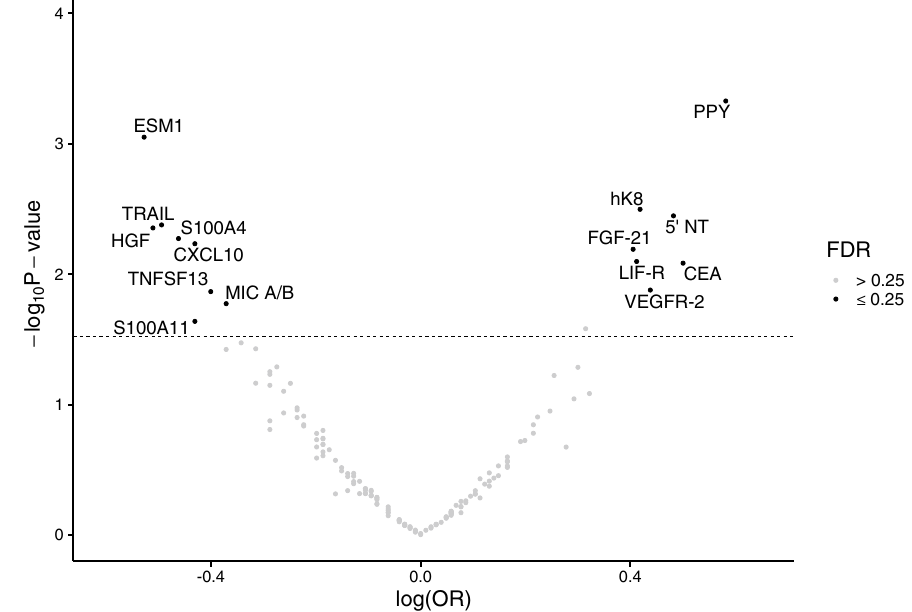
Figure 1. Volcano plot depicting results from the discovery phase of the study. Odds ratios were calculated using conditional logistic regression based on individuals’ baseline- and repeated values, separated in time. The model was adjusted for smoking status, BMI, and level of education. The dotted line represents FDR = 0.25.